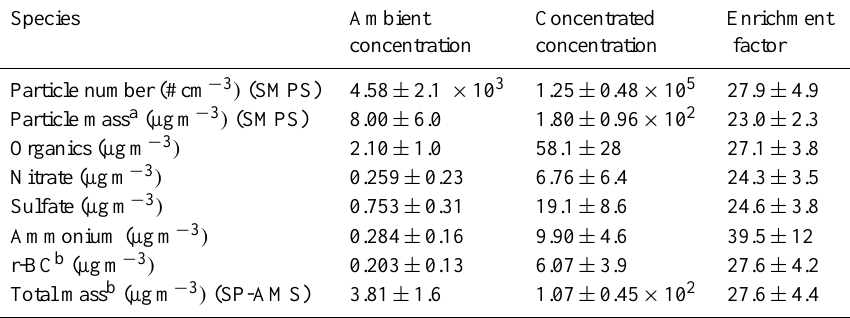
Table 2. Concentrations and EFs (average ± SD) of particle number and mass, SP-AMS species and total mass from the SP-AMS measured for ambient and concentrated aerosols. SP-AMS species are calculated with the collection efficiency of